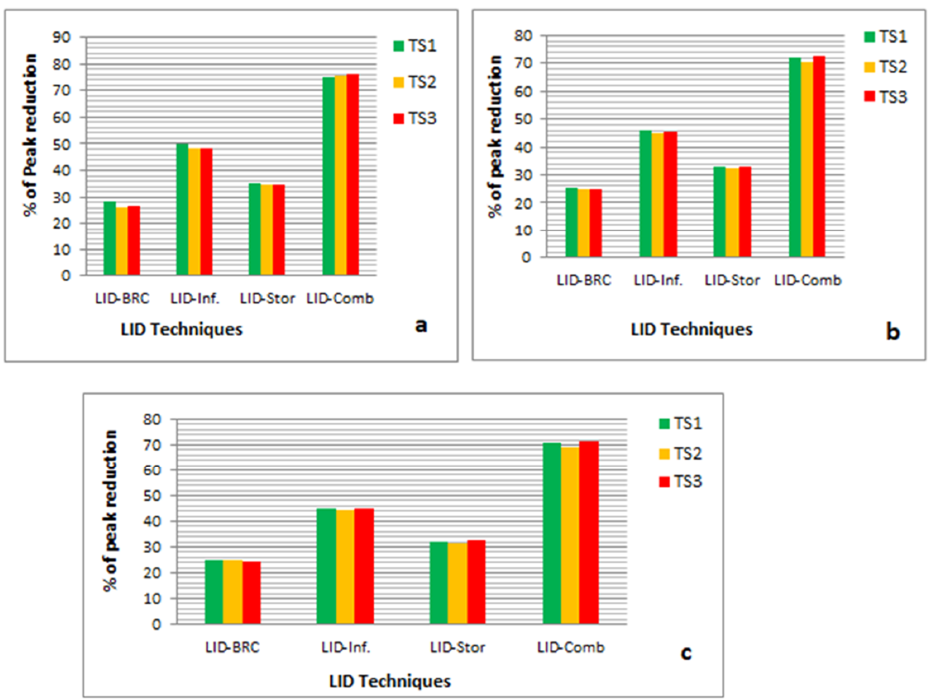
Figure 12. Effect of various LID methods on peak runoff reduction under various rainfall patterns and rainfall durations of: ( a ) 10 min; ( b ) 30 min and ( c ) 1 h.